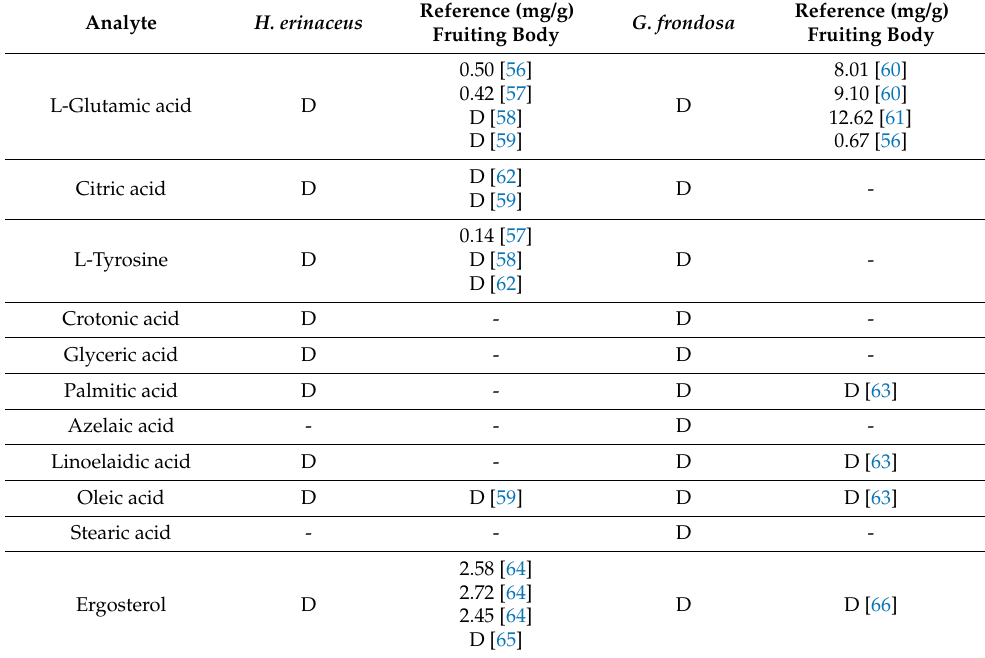
Table 1. Cont. Analyte H. erinaceus